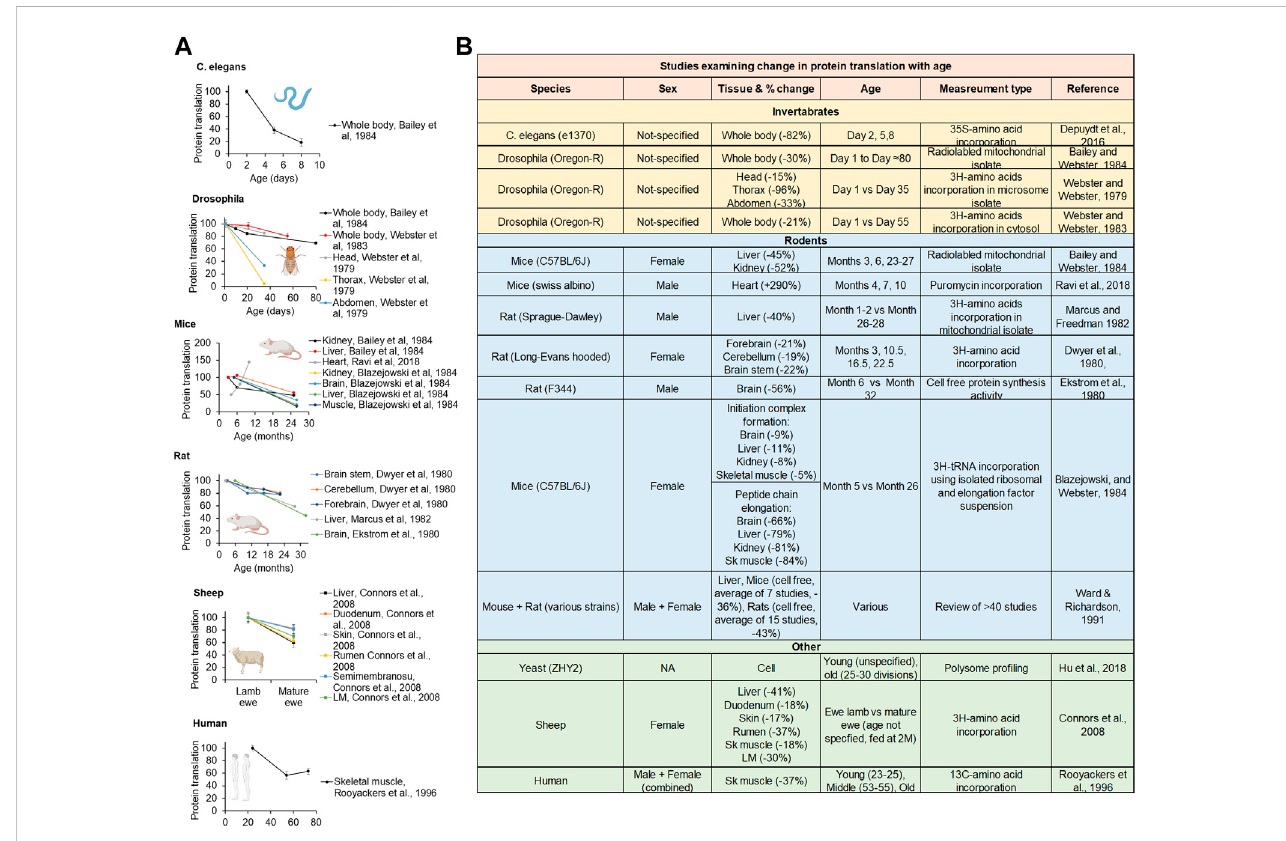
FIGURE 3 Lifetime protein translation dynamics. (A) Replotted protein translation rates across lifespan from studies in C. elegans , Drosophila , mice, rats, and humans. (B) Table of studies examining protein translation rates comparing young and old animals. Created with BioRender.com.